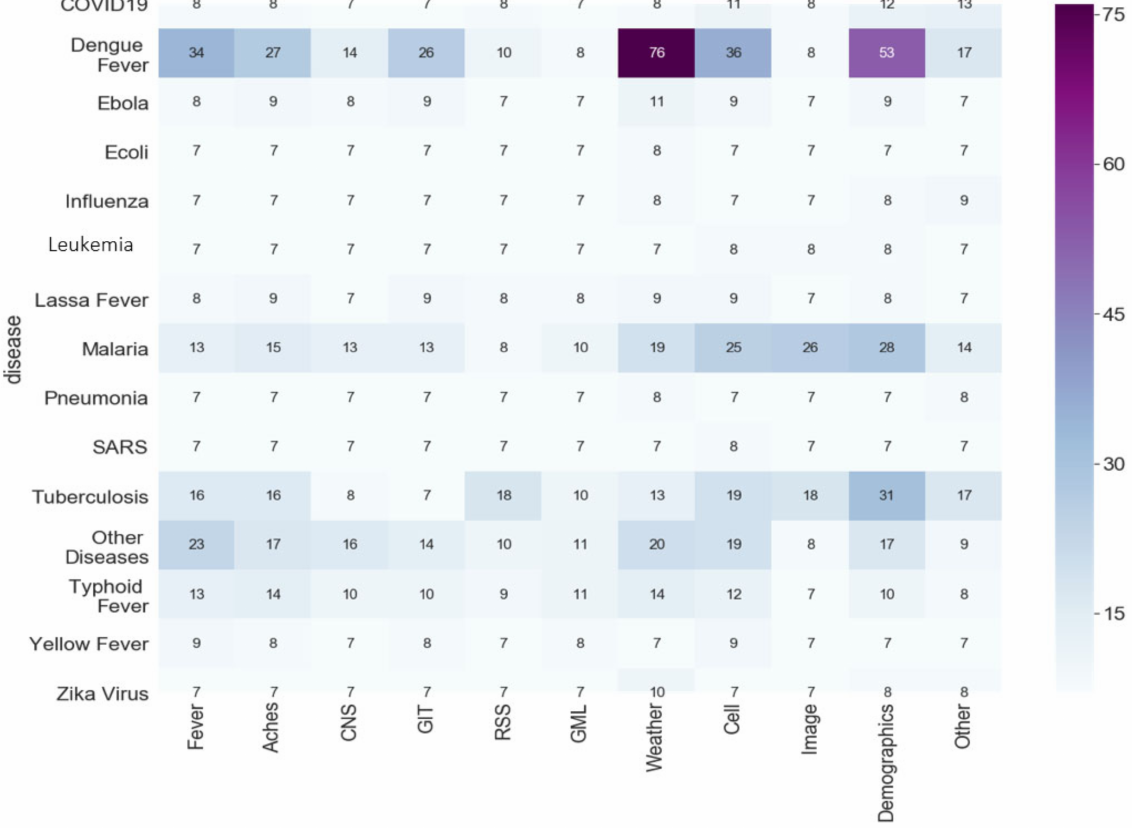
Figure 12. Heat Map of the diseases covered by the